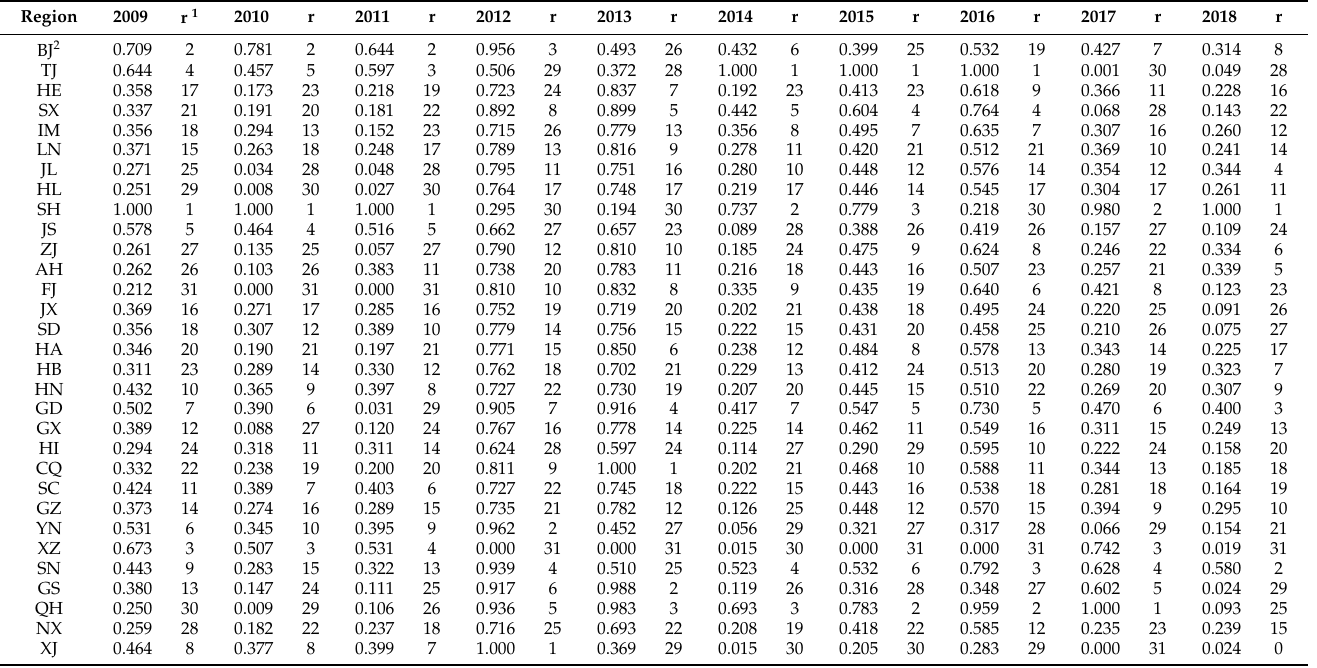
Table 7. System coordination degrees of the provinces.